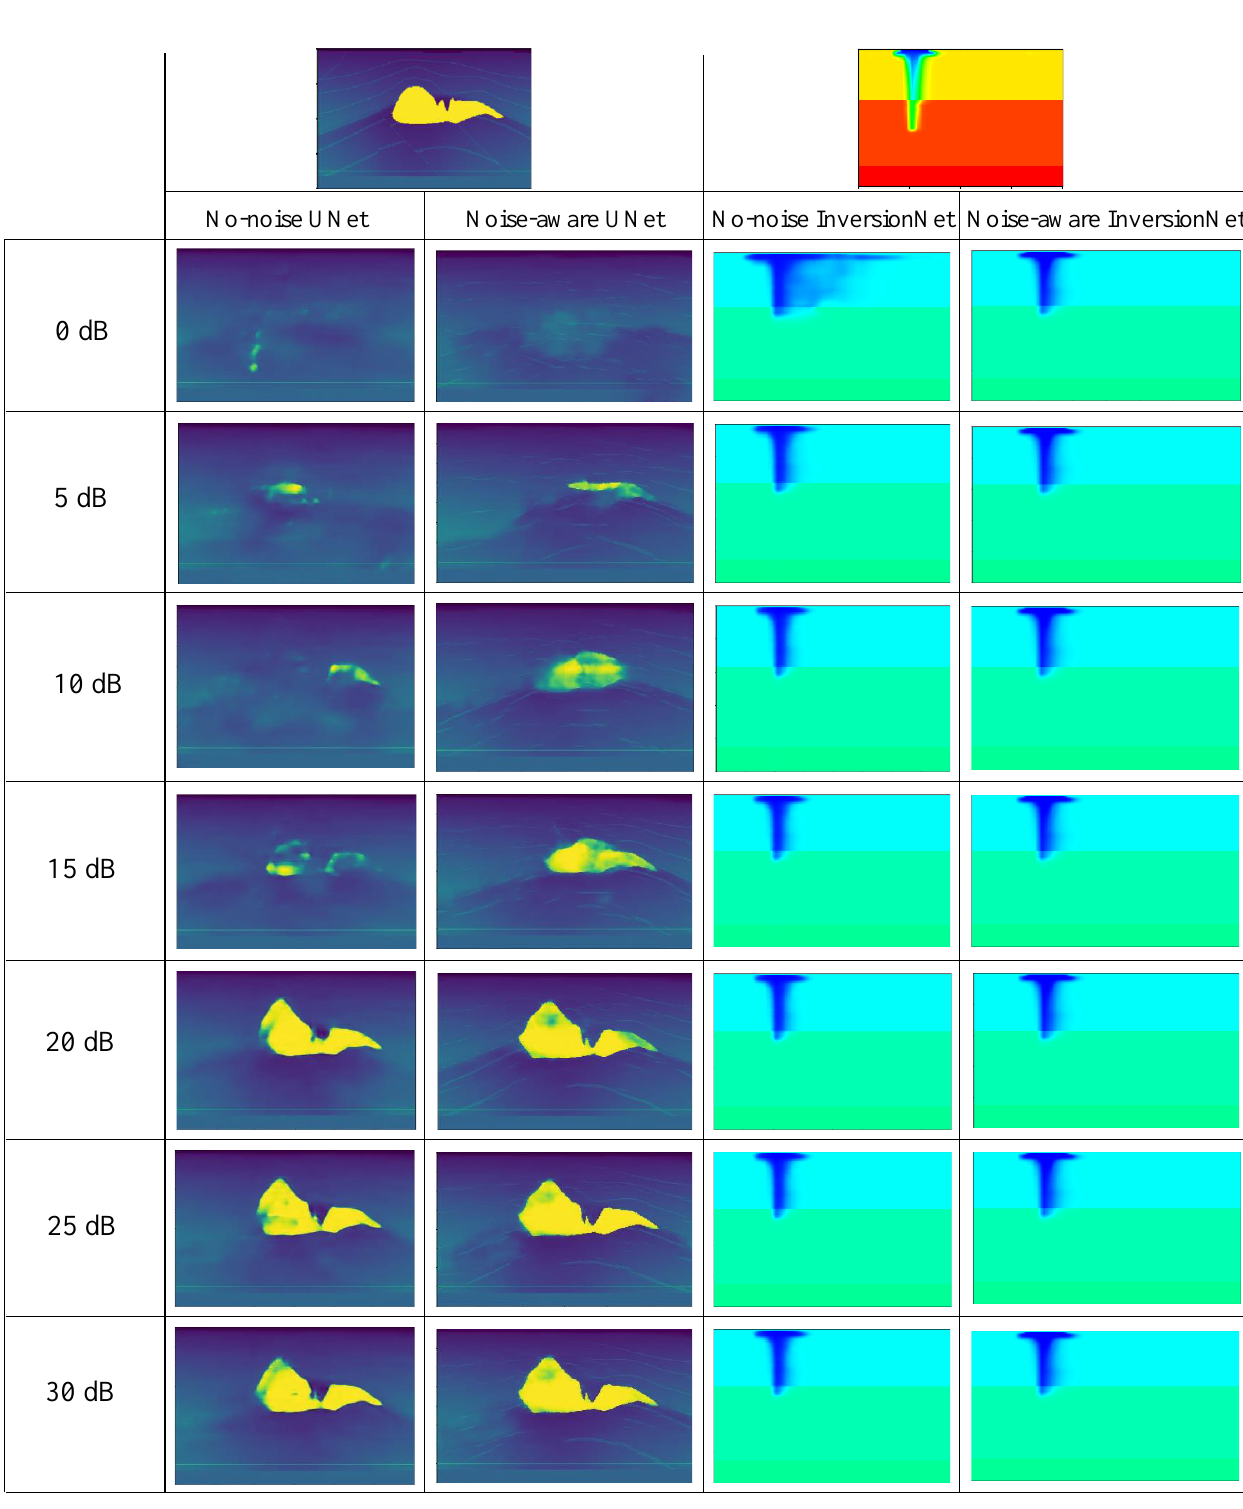
Figure 12. Effect of noise at different SNRs on reconstructions predicted by no-noise and noise- aware